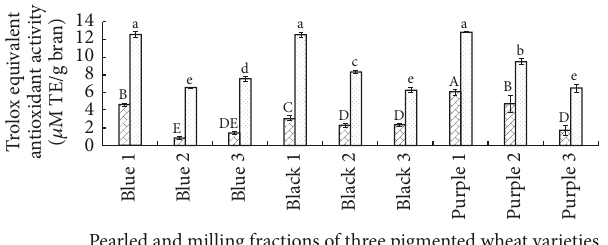
Figure 2: ABTS ∙+ scavenging capacity of the free and bound phenolic acids in the bran fractions of three pigmented wheat varieties. a Values are means of three determinations ± standard deviation, determined by HPLC analysis. b The same letters are not significantly different ( 𝑃 < 0.05 ). Blue: blue wheat; Black: black wheat; Purple: purple wheat; 1: outer bran; 2: coarse bran; 3: shorts; FPA, free phenolic acid; AHPA, alkaline-hydrolysable phenolic